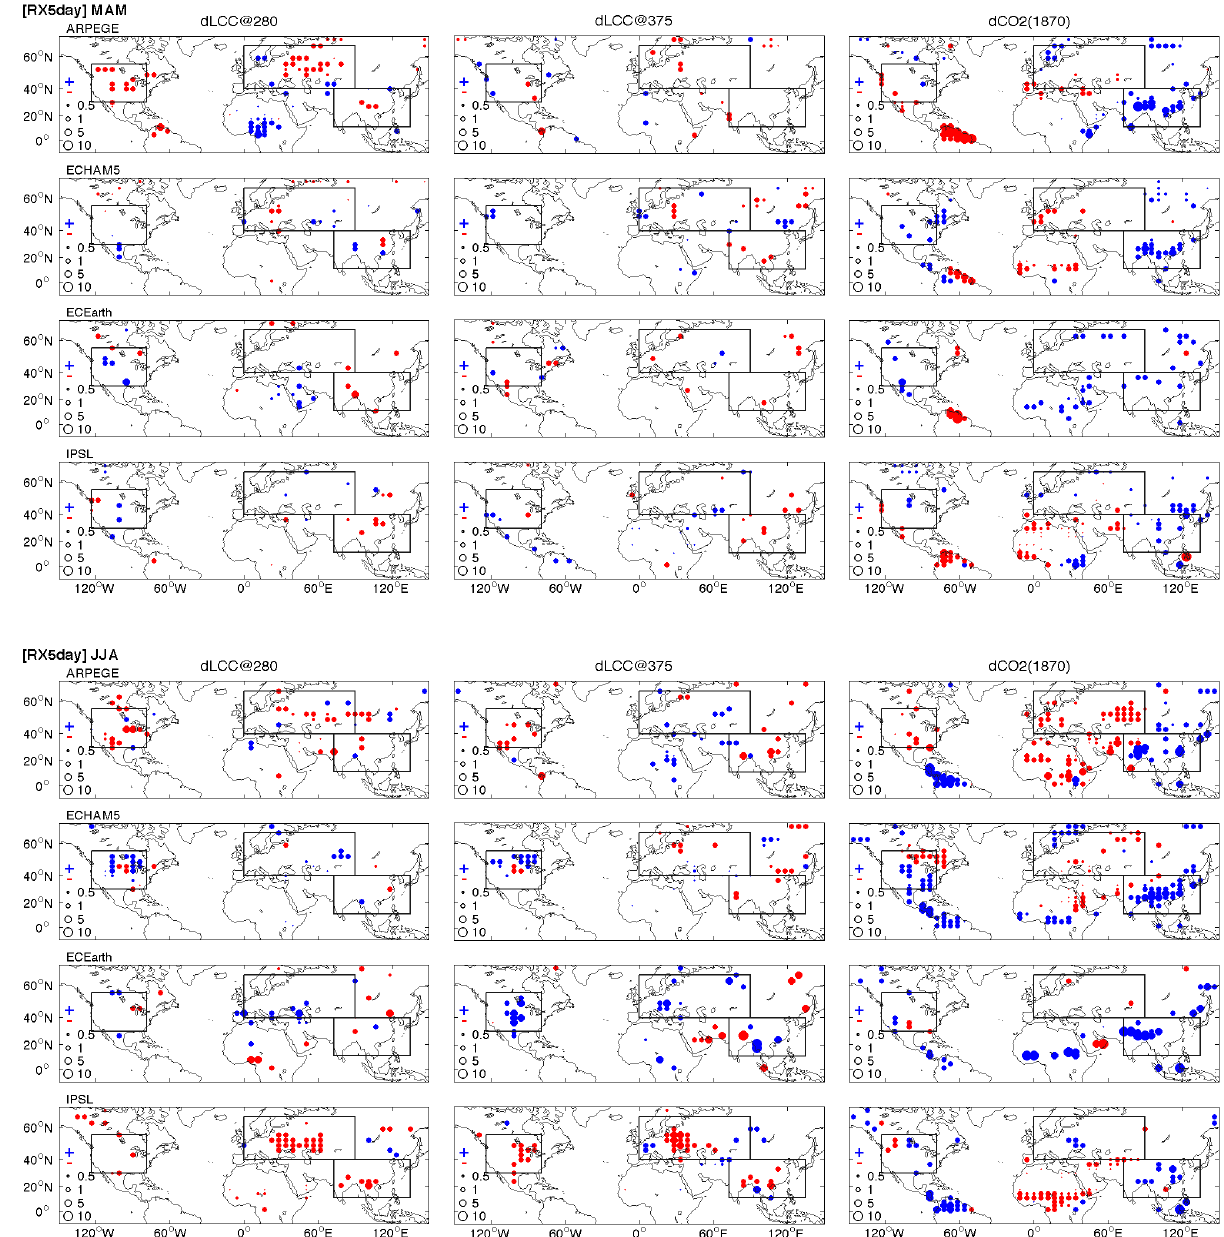
Fig. 9. As Fig. 4 but for the maximum rainfall occurring over a 5 day consecutive period (RX5day, mm). Note that for this index, blue indicates increased rainfall and red indicates decreased